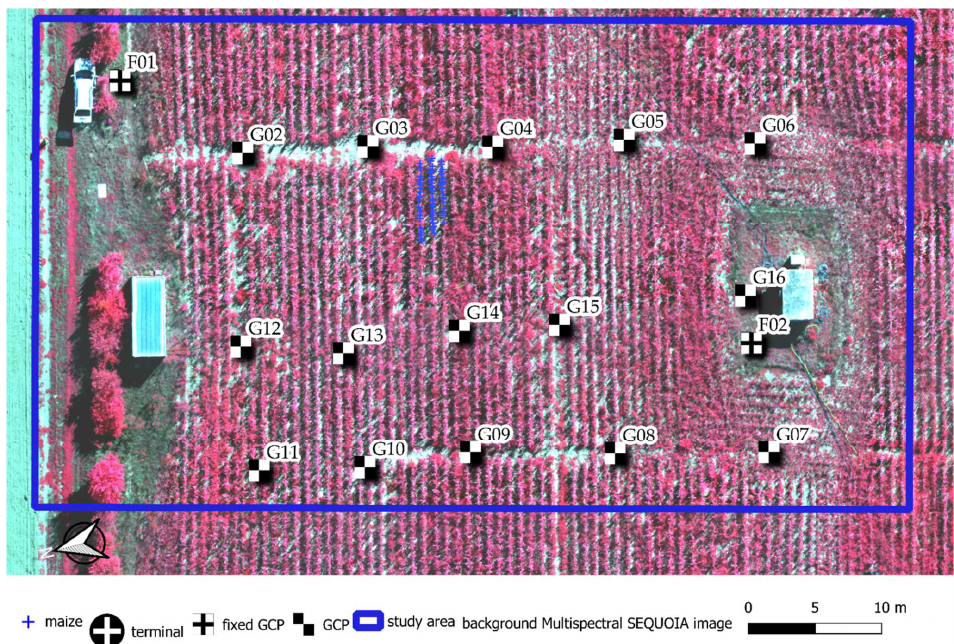
Figure 10. Location in the study area of the 17 GCPs and 70 marked maize plants.